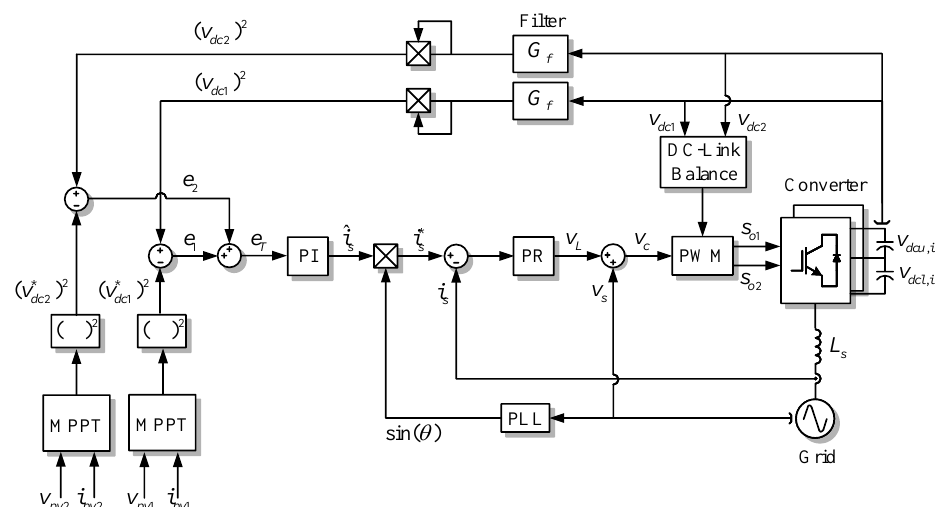
Figure 4. Single-phase voltage-oriented control strategy for the proposed 5L-CTNPC